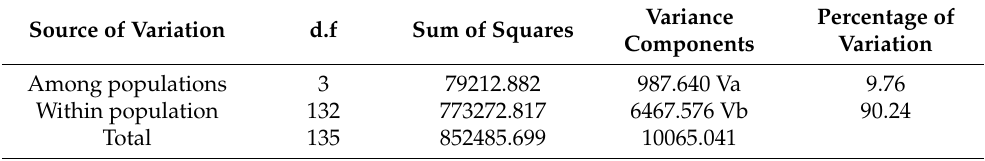
Table 2. Population variation components and fixation